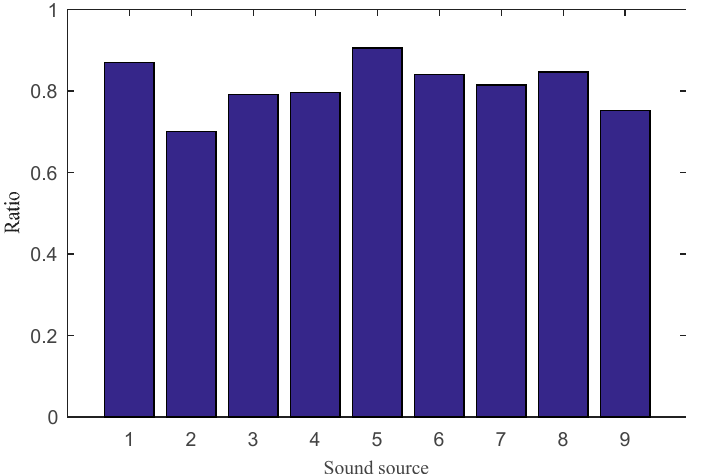
Figure 6. The recovery ratios of the nine sound sources in the